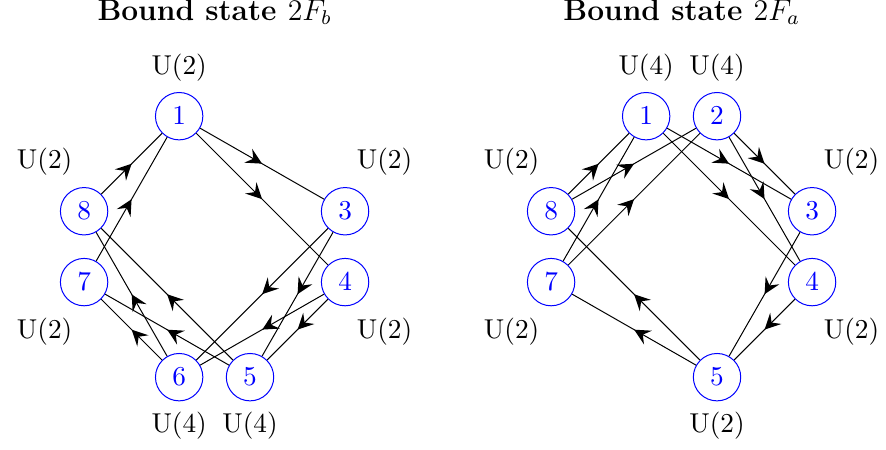
Figure 5 . Partial quiver for the bound states 2 F b (left) and 2 F a (right) of model I.